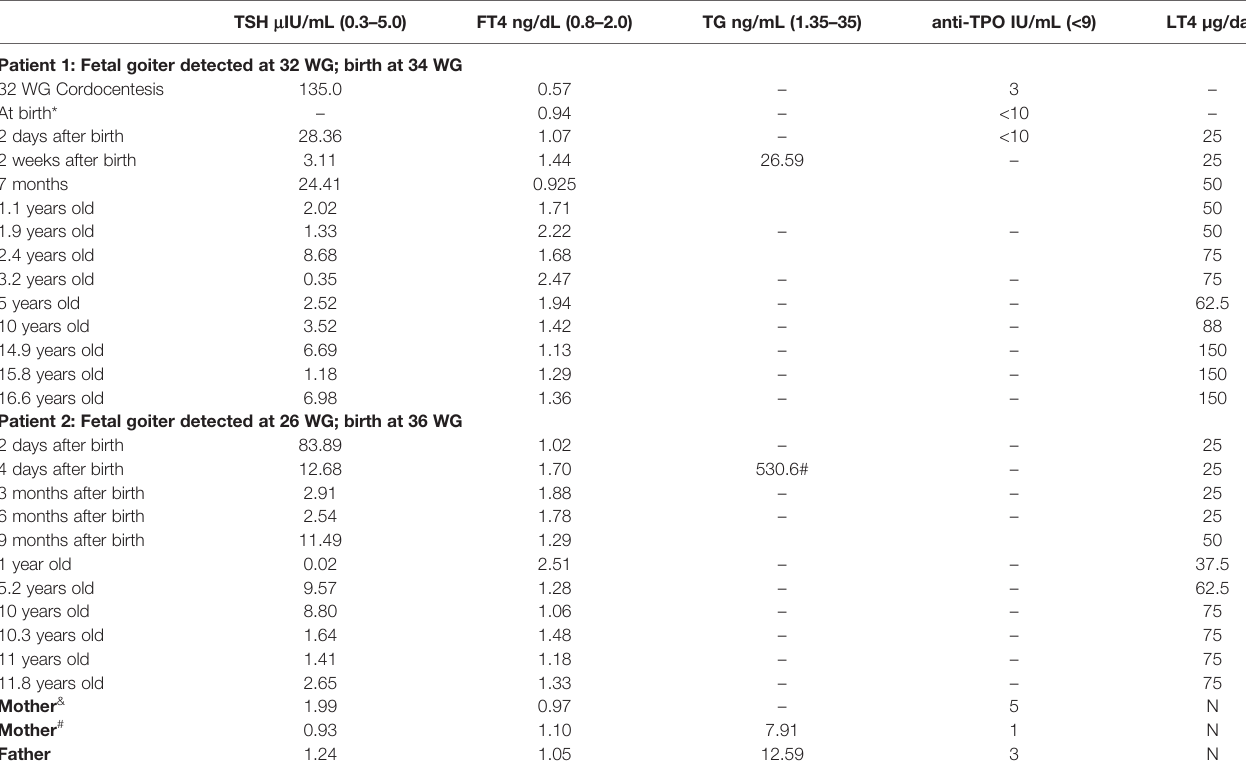
TABLE 1 | Thyroid hormone status of Patients 1 and 2 and of their parents and LT4 dose over time. TSH m IU/mL (0.3 –